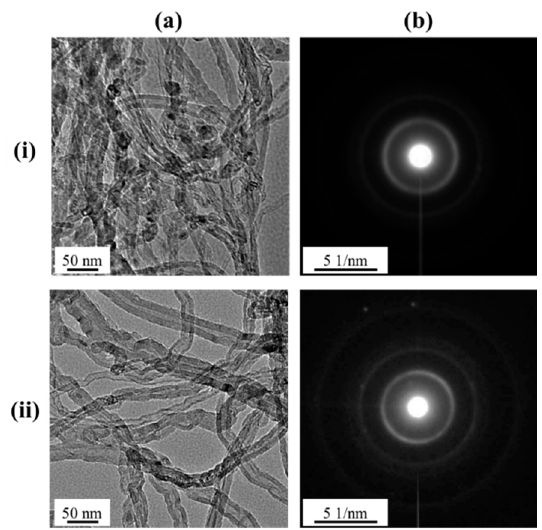
Figure 8. TEM images (a) and electron diffraction patterns (b) of CNTs grown with nanoparticles ( i ) and ( ii ).